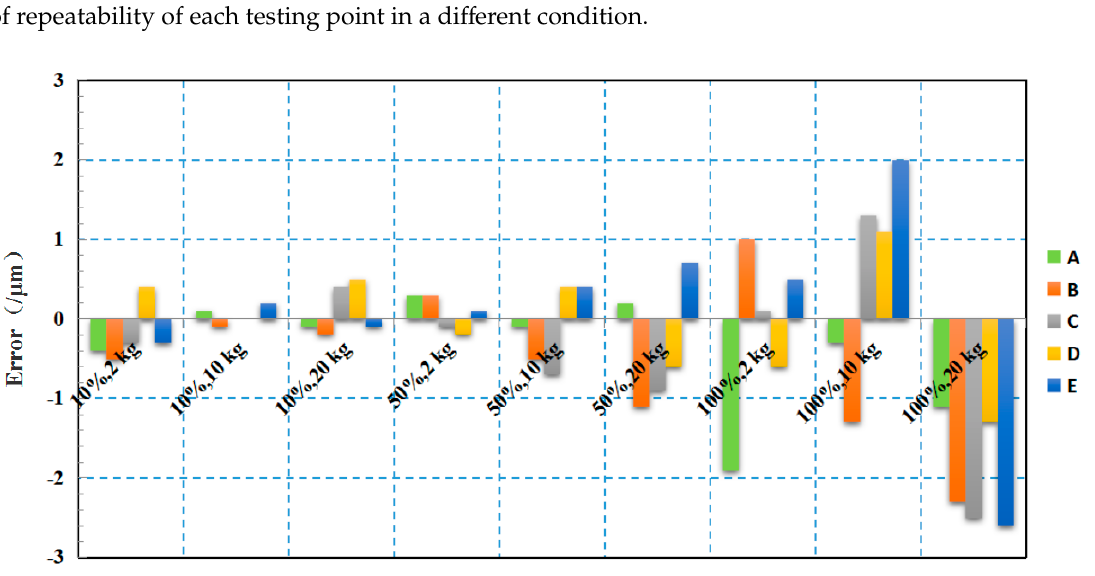
Figure 29. The errors of repeatability of the testing points between the original and the optimized upper upper arm.